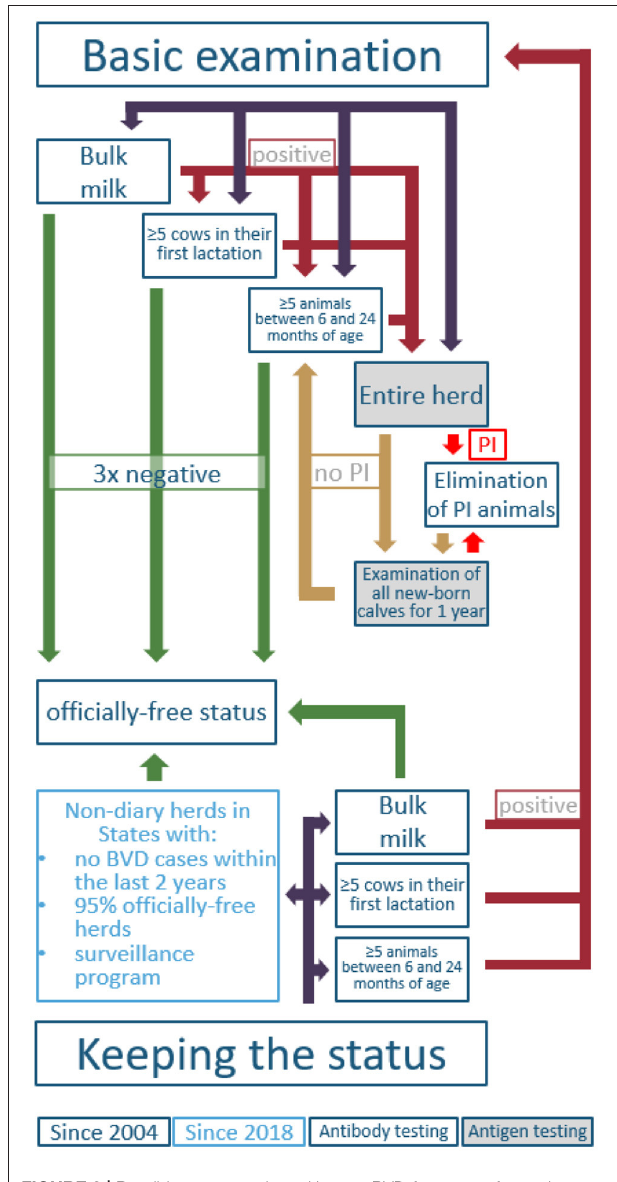
FIGURE 6 | Possible ways to gain and keep a BVD-free status for cattle holdings in Austria, according to the BVD legislation (AL14). PI, persistently infected